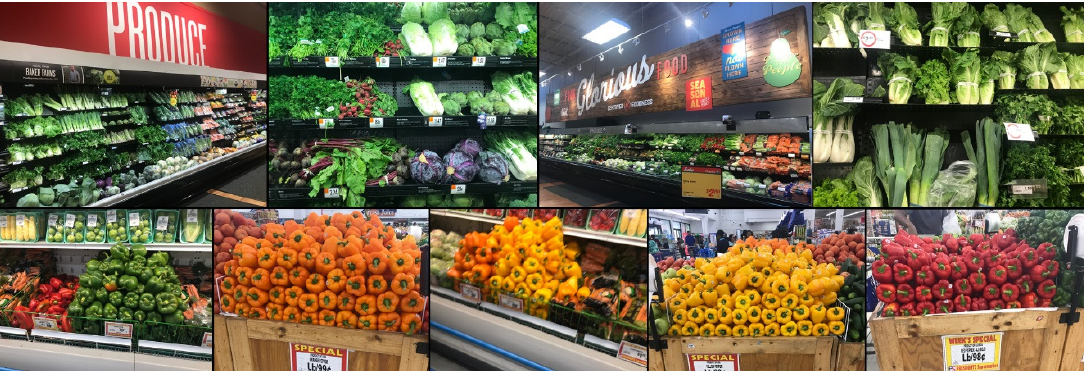
Figure 1. Representative images from supermarkets. Top row: Representative pictures of Supermarket #2 in District 98 (first), Superstore #1 in District 97 (second), Lucky Market in District 98 (third), and Save A Lot, District 94 (fourth). Bottom row: Representative pictures of Presidente in District 102, an independent store. This store had an increased abundance of various types of bell peppers.